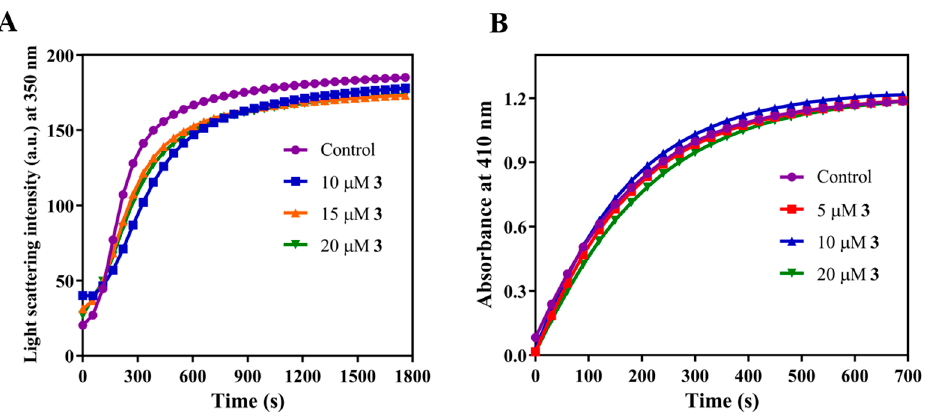
Figure 8. Compound 3 does not inhibit the activity of tubulin and alkaline phosphatase. ( A ) Mammalian tubulin (13 µM) in PEM buffer was polymerized after incubation with increasing concentration of 3 and monitored using light scattering at 350 nm. The spectra are representative of three independent sets of experiment. ( B ) The activity of Alkaline phosphatase incubated with increasing concentrations of 3 was monitored using absorbance at 410 nm after addition of PNPP substrate. The spectra are representative of three independent sets of